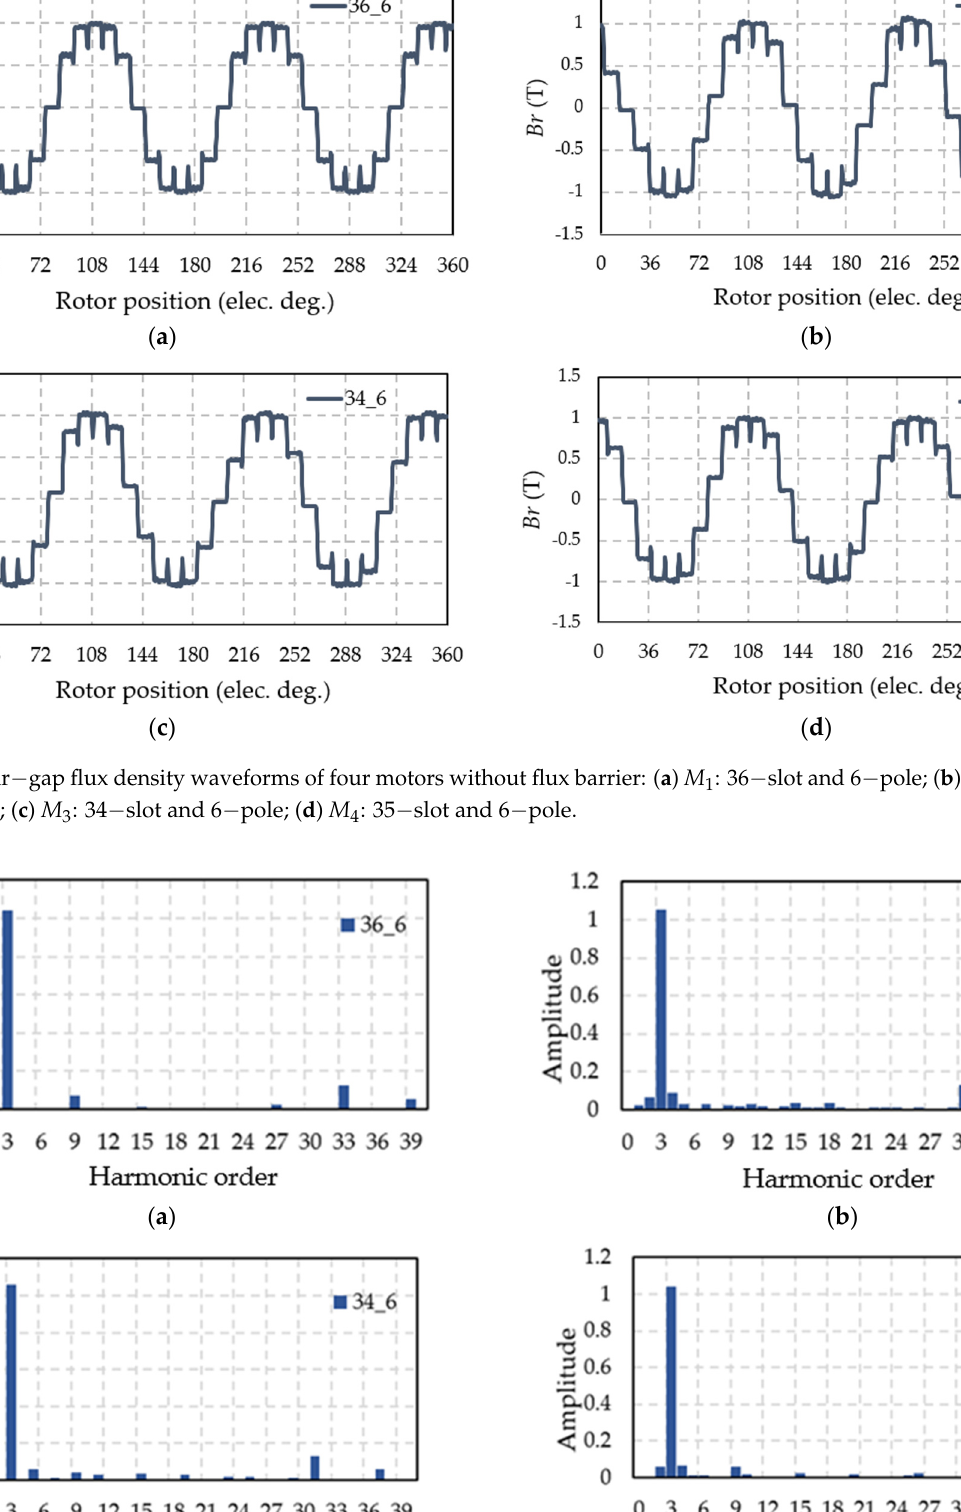
Figure 4. 2D − model structure of two motors: ( a ) motor with two − layer flux − barrier and PM; ( b ) motor without flux − barrier.